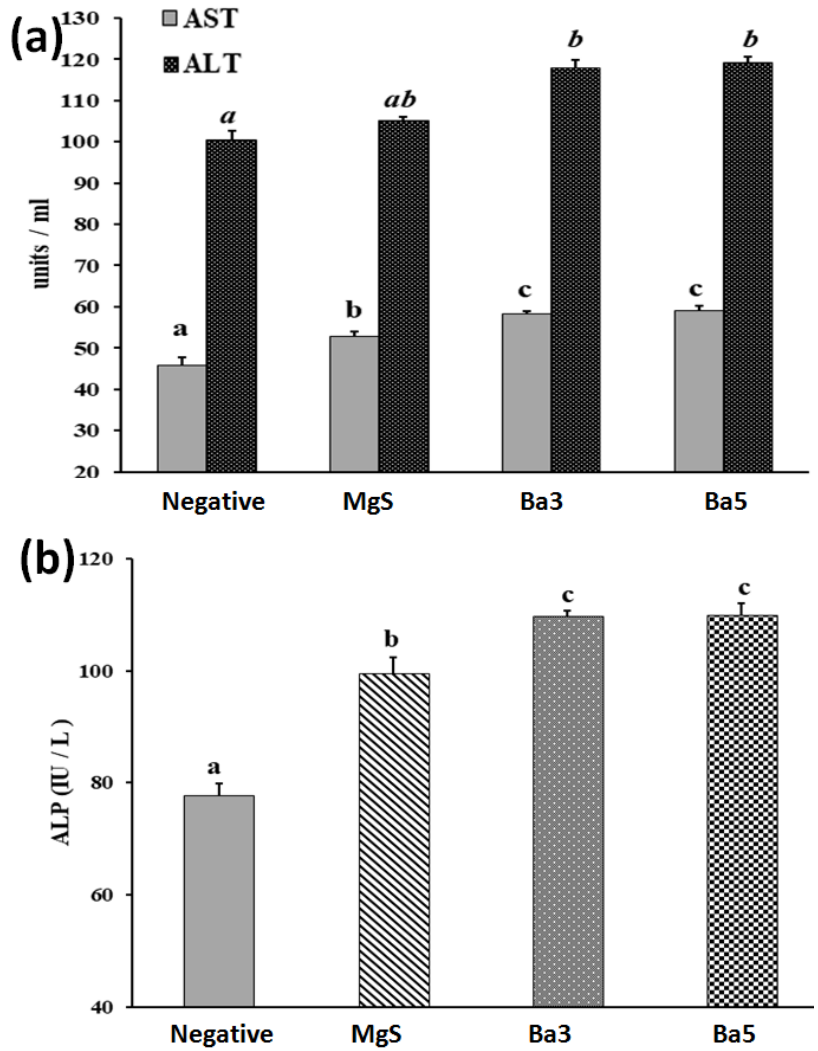
Figure 9. Effect of MgS nanopowders free from and doped with BaO on ( a ) hepatotoxicity indices and ( b ) alkaline phosphatase (ALP) in tibia-fractured rats ofdifferent experimental groups: Sham Control, MgS, MgS doped with 3% BaO (Ba3), MS doped with 5% BaO (Ba5). Data are presented as mean ± SE of mean. Statistical analysis was conducted using ANOVA followed by Duncan test ( n = 5, p ≤ 0.05). Mean with different superscripts (a,b,c) are significant at p ≤ 0.05. Bars having the same superscripts are not significantly different from each other, while those having different superscripts are significantly different from each other (ALT: alanine amino transaminase, AST: aspartate amino transaminase and ALP: alkaline